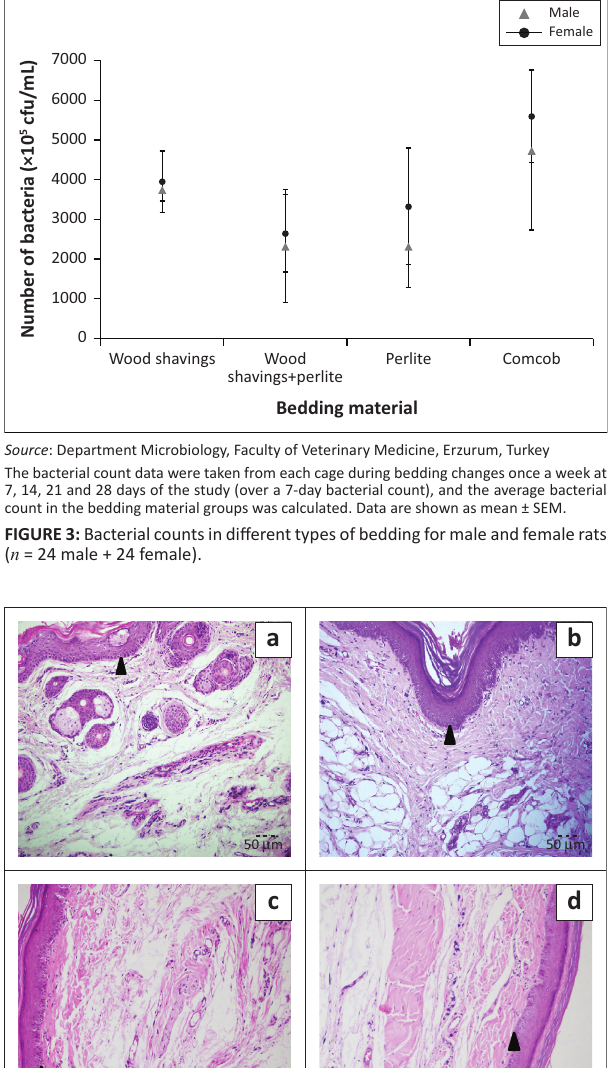
FIGURE 4: Bedding-change frequency (once per week): Degenerative changes (arrow head) in epithelial cells, H&E, (a) perlite (severe), (b) wood shavings- perlite (moderate), (c) wood shavings (mild) and (d) Corncob (mild).